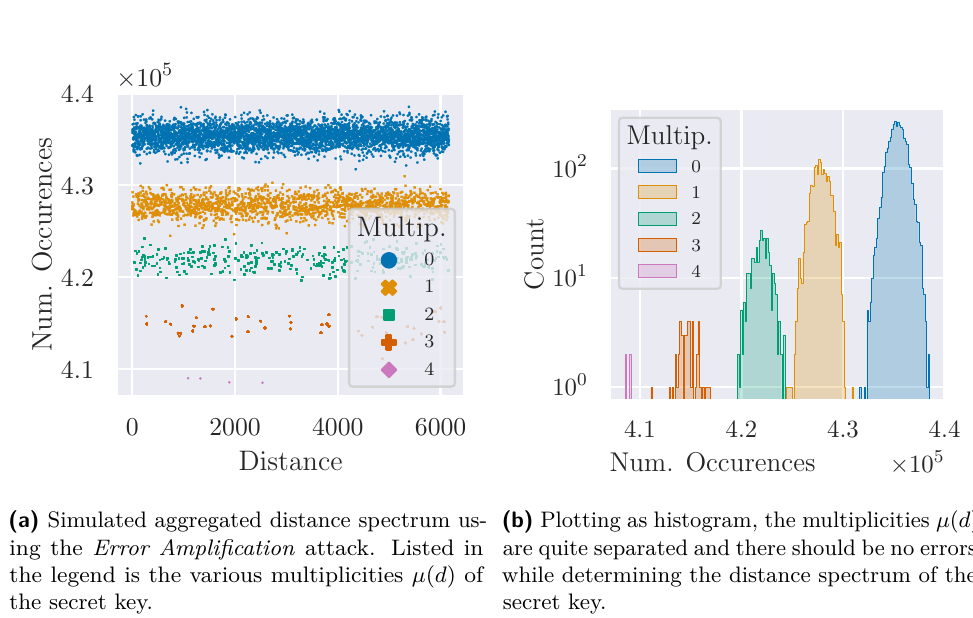
Figure 7: Data is generated using N f = 8 . 5 × 10 6 decoding failures and a distinguisher with (cid:15) = 0 . 01. For each distance is listed the number of occurrences that the specific distance was included in an error pattern that resulted in a decoding failure. The stratification into separate layers for each multiplicity is clearly